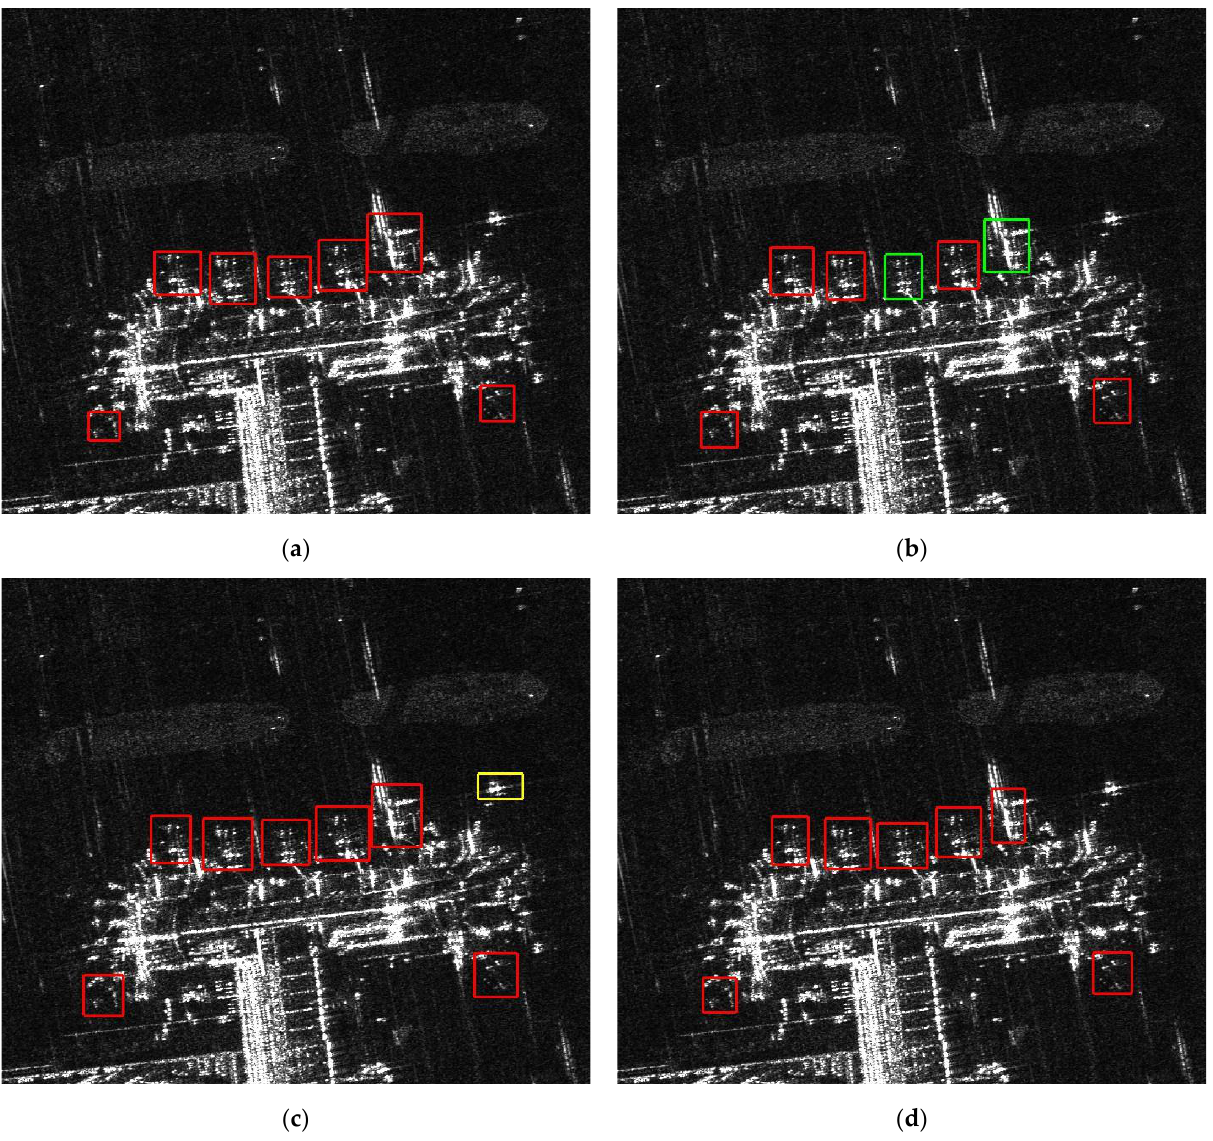
Figure 8. The results for scene I of Beijing Capital Airport. ( a ) The ground truth from Gaofen-3. ( b – d ) The detection results by YOLOv5, YOLOX, and SOAEN, respectively. The correct detection, the missed detection, the false alarms, and the inaccurate bounding boxes are indicated by red, green, yellow, and blue boxes, respectively.